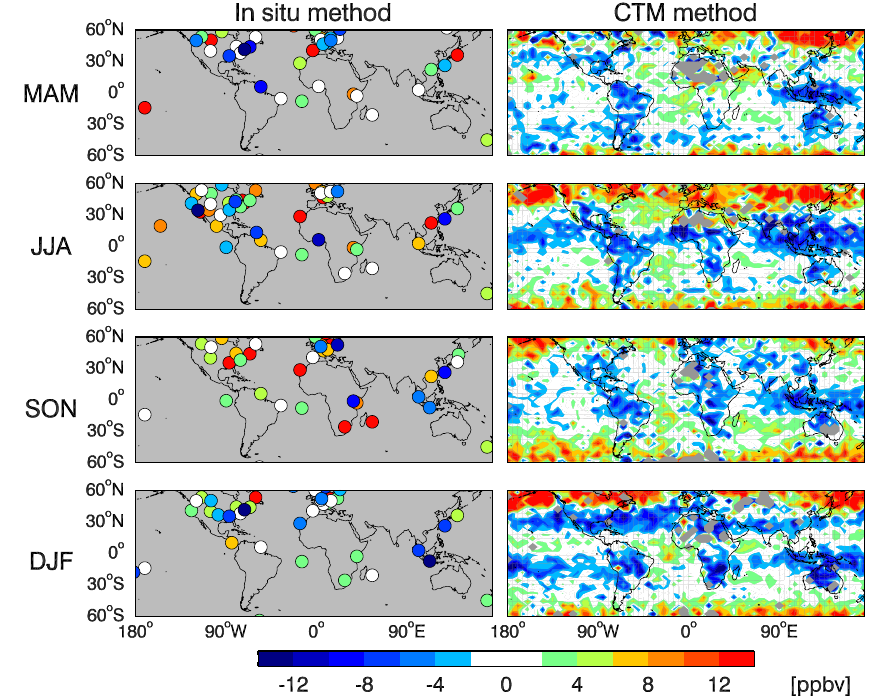
Fig. 7. Seasonally averaged TES minus OMI ozone differences (ppbv) at 500hPa computed by the in situ method (left) and the CTM method (right). The in situ method is applied to 2005–2007 data while the CTM method is applied to 2006 data. Red colors indicate that TES ozone is higher than OMI. Gray areas indicate lack of data meeting the retrieval quality